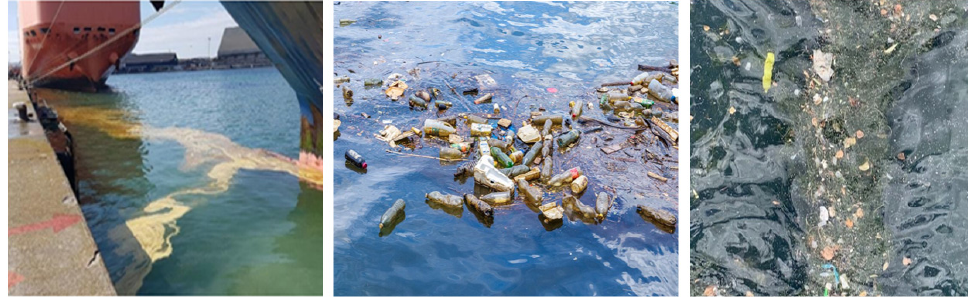
Figure 4. Right image: Spill class example. Center image: Waste class example. Left image: Mixed Spill and Waste example.